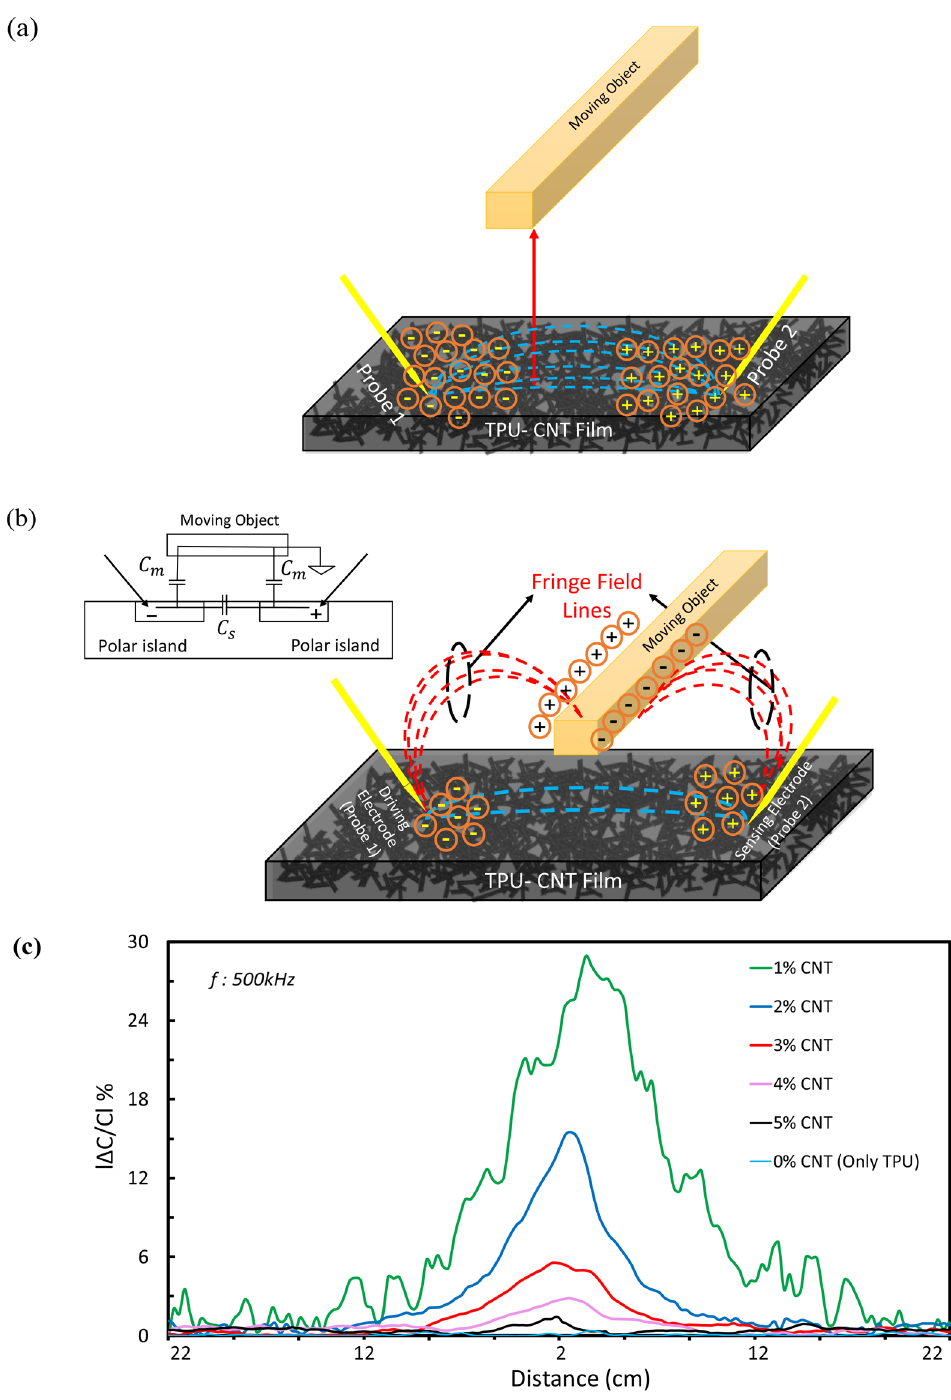
Figure 2. Electrical field lines of proximity sensor and maximum sensitivity. ( a ) Moving object at the farthest distance from sensor (i.e., 220 mm), no electrical field lines exist between probs and object. Bent electric filed lines (self-capacitance) are shown. ( b ) Moving object at the closet distance to sensor (i.e., 20 mm), mutual capacitance becomes clear. Shunting of the initial electeric lines causes very strong and scattered fring field between object, film and probes, and capacitance drops radically. ( c ) Maximum sensitivity comparison of different wt%. CNTs. Absolute percentage change of capacitance to the initial capacitance is plotted against